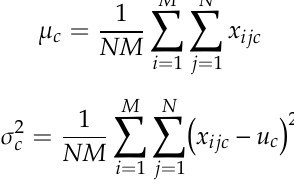
) 𝑦 = 𝑥 + ℱ(𝑥 , 𝒲 (cid:3039)(cid:2878)(cid:2869) (cid:3039) (cid:3039) (cid:3039)